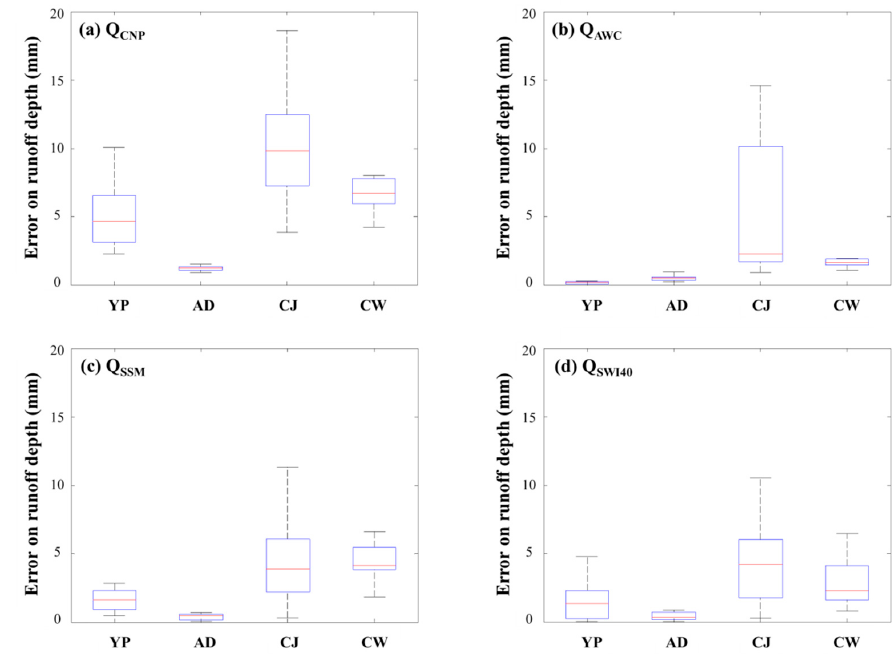
Figure 6. Boxplot of absolute error in the estimated runoff depth at each site: ( a ) Q CNP was predicted using the CN estimated from CN–P relationship; ( b ) Q AWC was predicted using the CN estimated from CN–P relationship; ( c ) Q SSM was predicted using remotely sensed surface soil moisture; and ( d ) Q SWI40 was predicted using soil wetness condition from T = 40.